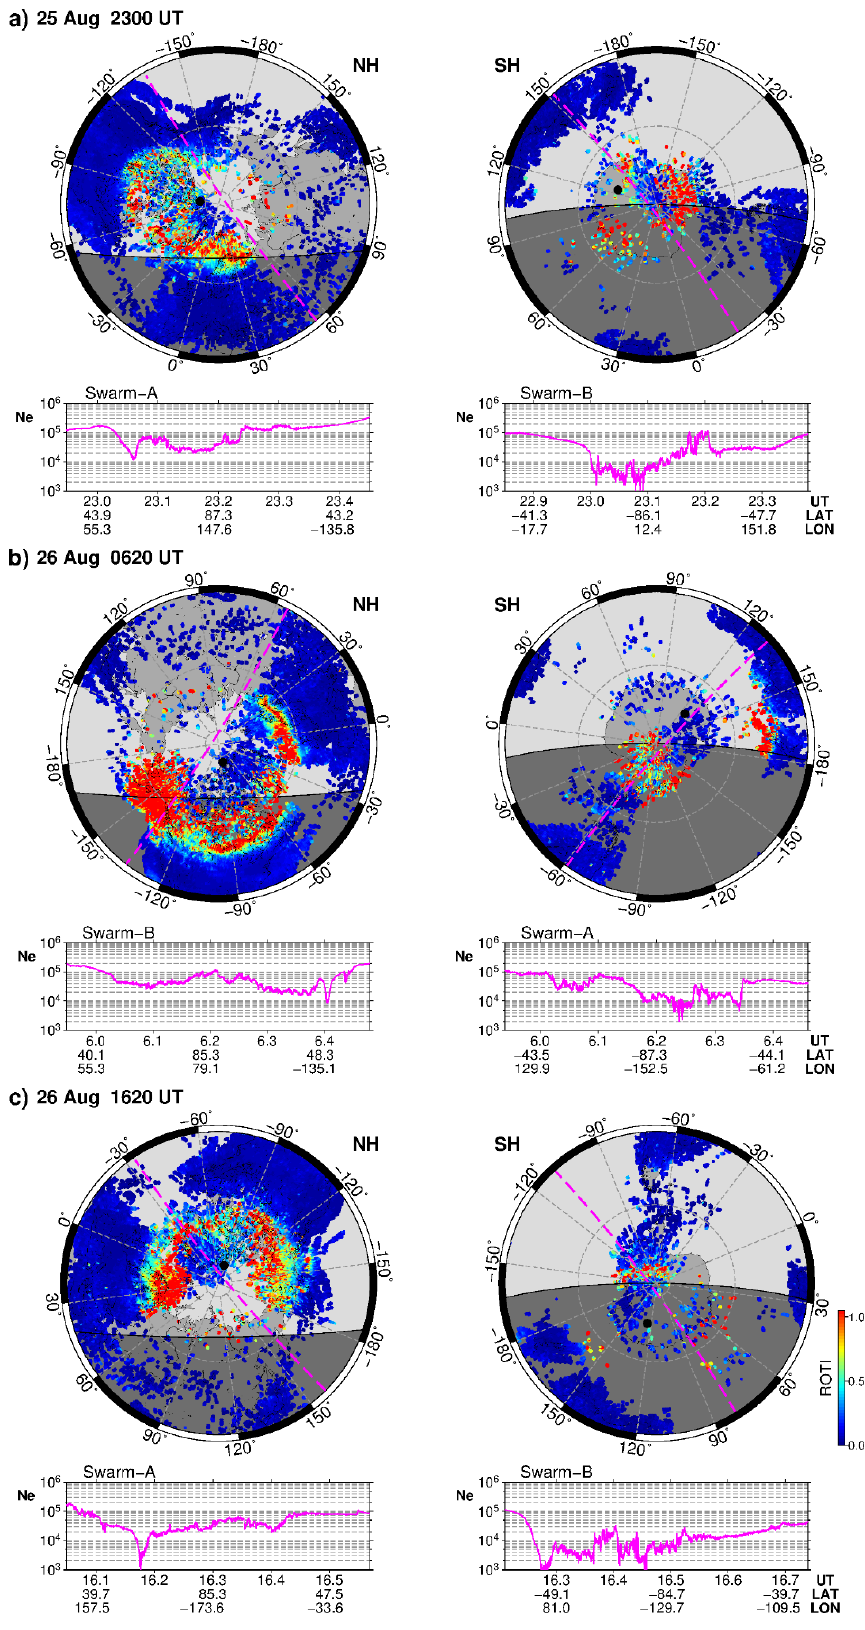
Figure 5. Two-dimensional GNSS ROTI maps in a polar view projection illustrating development of the auroral irregularities oval over the Northern (NH) and Southern (SH) Hemispheres for ( a )